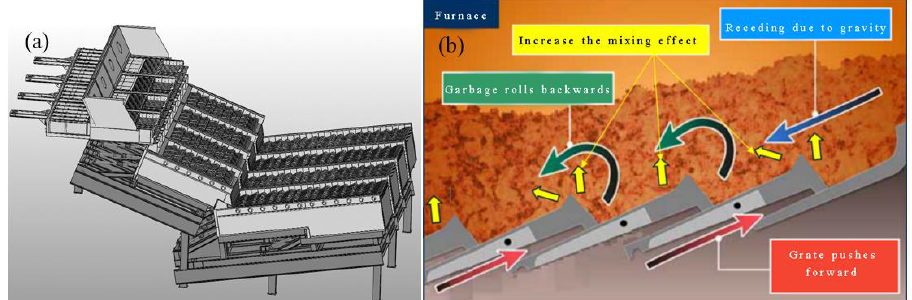
Figure 1. Structure schematic of a V-type grate: ( a ) Description of overview grate panel; ( b ) Description of operation condition.